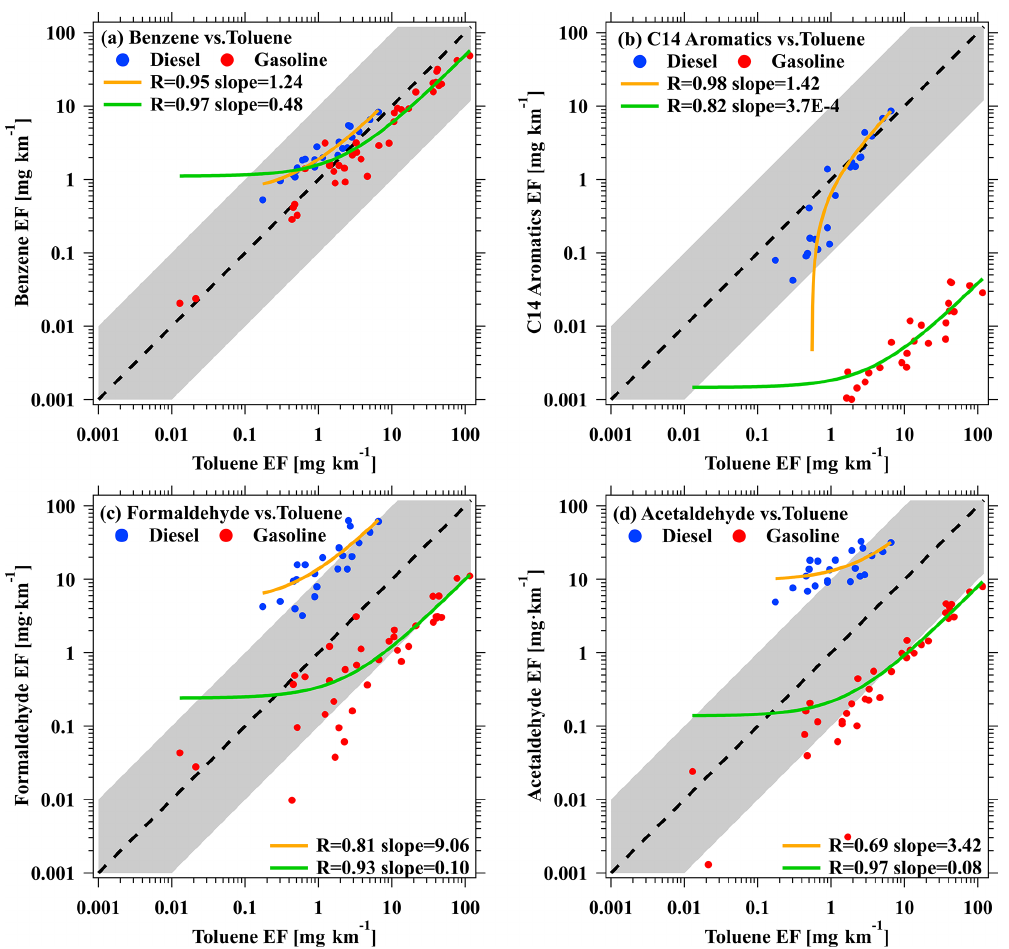
Figure 10. Scatterplots of the determined mileage-based emission factors of (a) benzene versus toluene, (b) C 14 aromatics versus toluene, (c) formaldehyde versus toluene, and (d) acetaldehyde versus toluene for gasoline and diesel vehicles. Each data point represents each test vehicle in this study. The green and orange lines are the fitted results for gasoline and diesel vehicles. The black line represents the 1/1 ratio, and the shaded areas represent the ratios of a factor of 10. The green and orange lines are the fits to gasoline and diesel points in each plot. Note that these linear fits are shown in curves in log–log space as a result of non-zero y